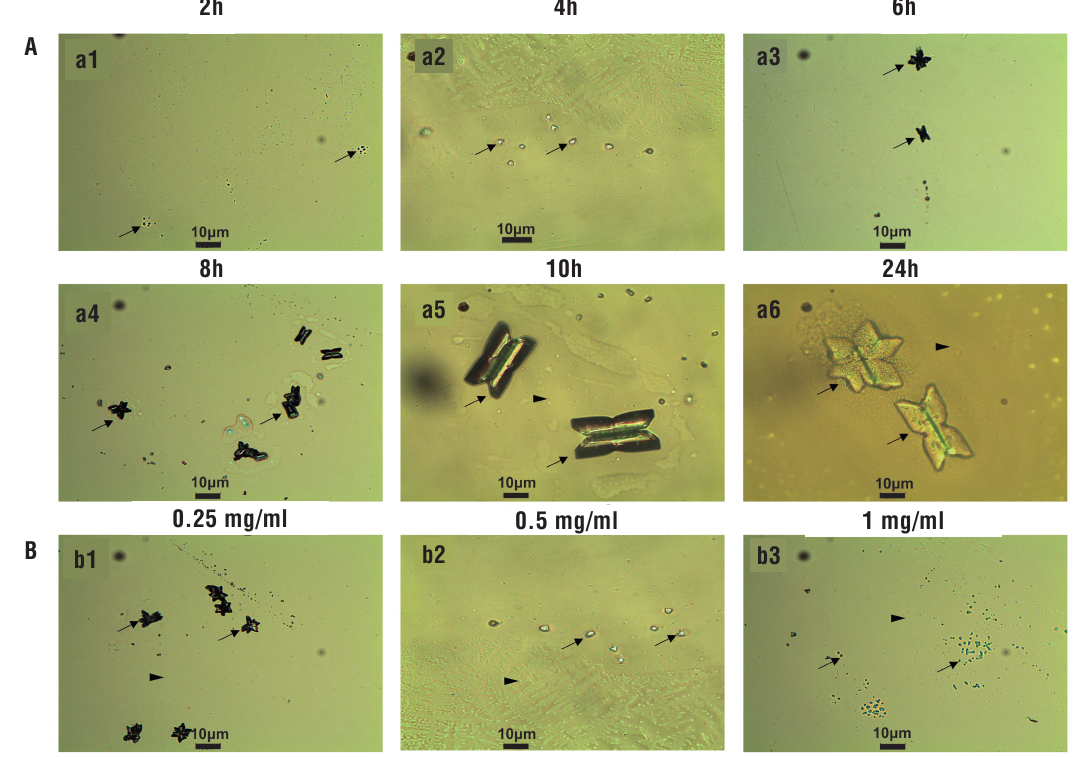
Figure 1 - Struvite crystals grown in artificial urine infected with Pseudomonas aeruginosa (a). Temporal growth pattern in control (a1-a6) (b). Inhibition of struvite crystals due to vitamin C treatment 24 h (b1:0.25 mg/mL, b2:0.5 mg/mL and b3:1 mg/mL). “Arrow” shows crystals and “arrowhead” shows